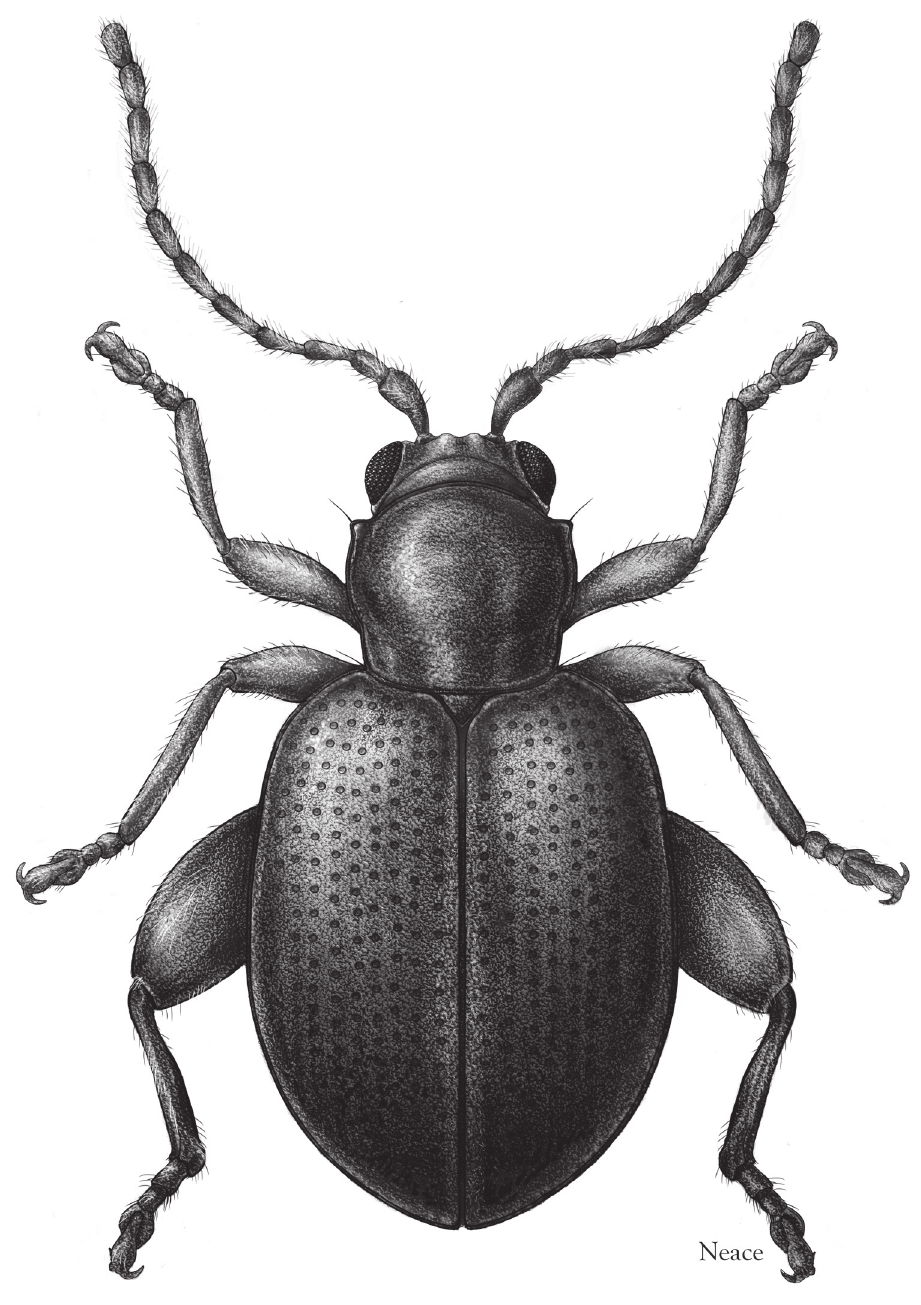
Figure 9. Andersonoplatus castaneus . Dorsal habitus, illustration by Meghan